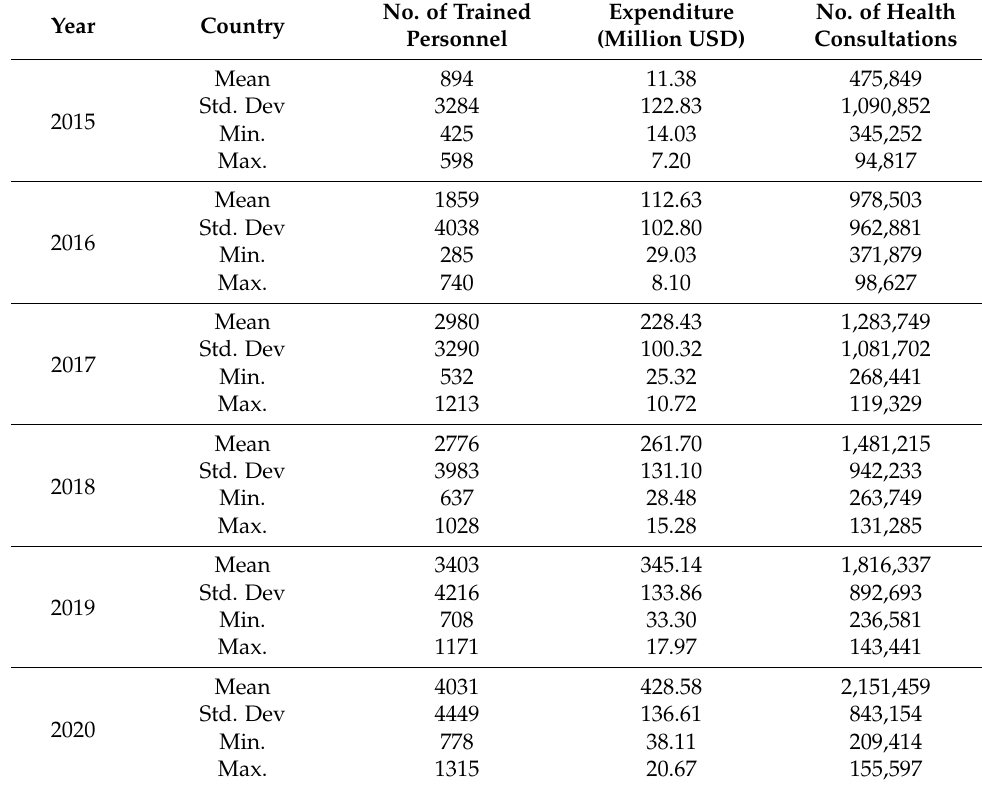
Table 1. Descriptive statistics of efficiency